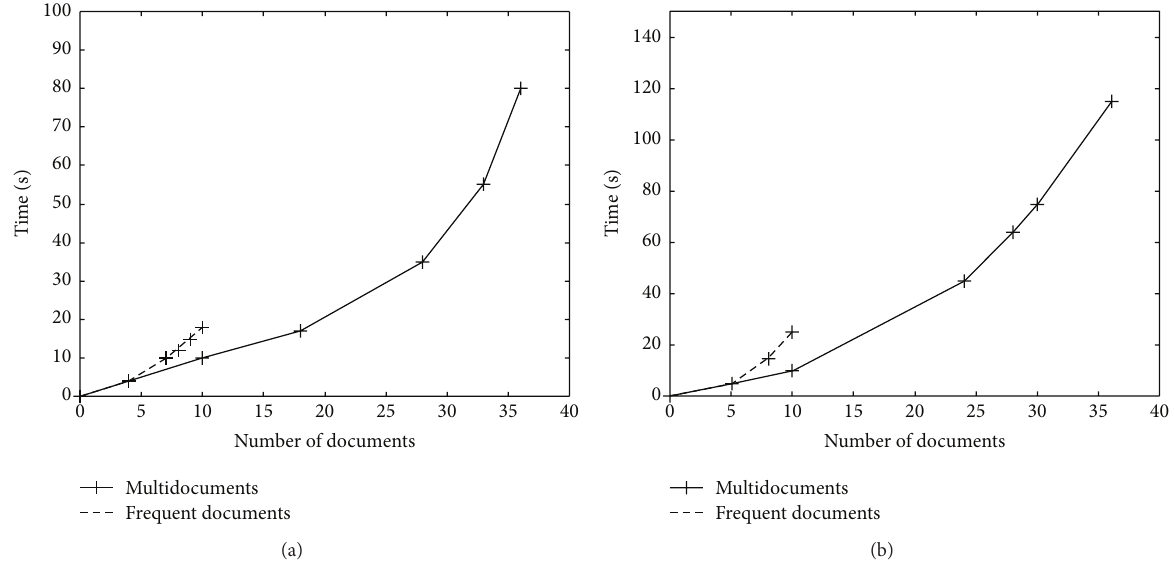
Figure 3: Comparison of frequent versus multidocument summarization: (a) Na¨ıve Bayesian classifier (proposed) and (b) MEAD (existing).